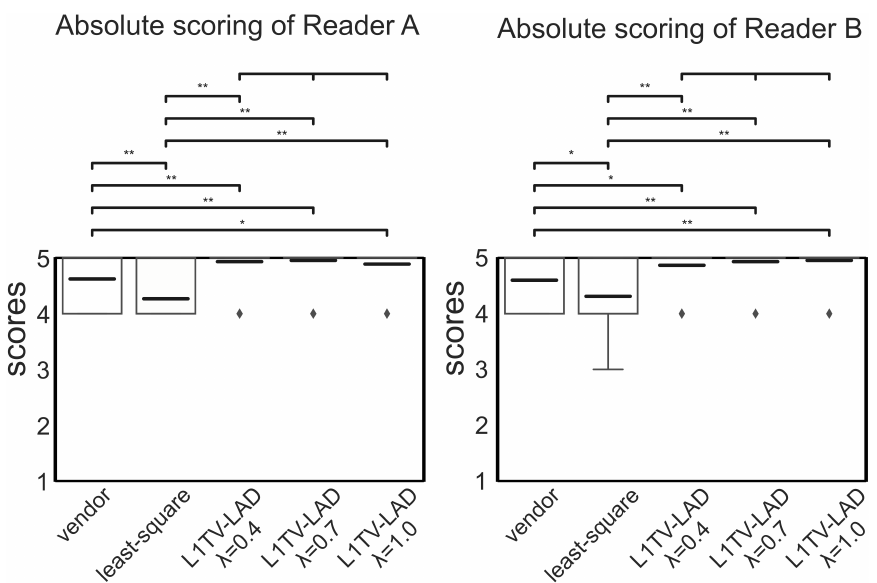
Figure 7. Boxplots of the absolute scores by two readers. box: the first and the third quantile, bold lines: mean, whisker: maximum and minimum (may overlapped with the box in most cases). Medians are overlapped by the box. (cid:7) : outliers. * p < 0.01, ** p < 0.001.